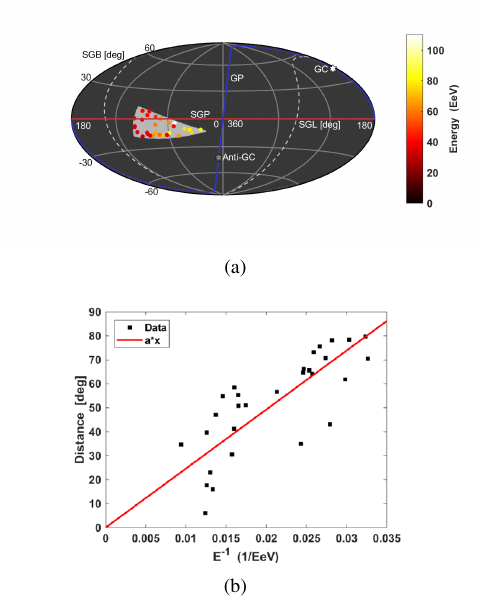
Figure 2. (a) Supergalactic Hammer-Aito ff projection of the maximum significance “wedge” at 18.3 ◦ SGB, -12.9 ◦ SGL. The correlation τ b = − 0 . 675 and with 29 data events has a pre-trial one-sided significance of 5.5 σ . The energy threshold is E i ≥ 30 EeV, wedge width W i = 30 ◦ , angular distance D i = 80 ◦ , and direc- tion φ i = 90 ◦ . (b) Scatter plot of 1 / E versus angular distance δ in the wedge.